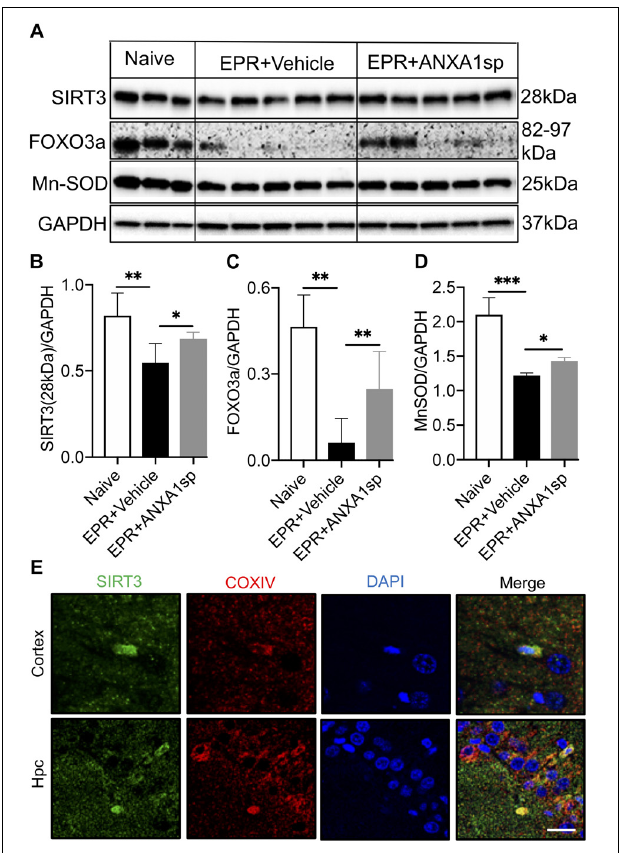
FIGURE 6 | Cerebral expression of Sirtuin-3 (SIRT3) and downstream regulated proteins after exsanguination cardiac arrest/EPR and ANXA1sp or vehicle treatment. (A,B) A significant reduction in SIRT3 (28 kDa short, processed, active form) was seen after EPR + vehicle treatment compared to naïve animals, and was rescued in ANXA1sp-treated animals. This was accompanied by similar expression changes for the forkhead box O3a (FOXO3a) transcription factor (C) , known to transactivate the antioxidant enzyme manganese superoxide dismutase (MnSOD) (D) . GAPDH was used as loading control (E) . At 24 h postoperatively, colocalization of sirtuin-3 (SIRT3) with the mitochondrial protein cytochrome c oxidase complex IV (COXIV) in cortical and hippocampal slides from ANXA1sp-treated animals was visualized via double immunofluorescence staining and confocal microscopy. Data presented as mean ± SD ( n = 3–7/group), ∗ P < 0.05, ∗∗ P < 0.01, and ∗∗∗ P < 0.001 compared to either naïve or vehicle controls analyzed by one-way ANOVA with Tukey’s multiple comparisons